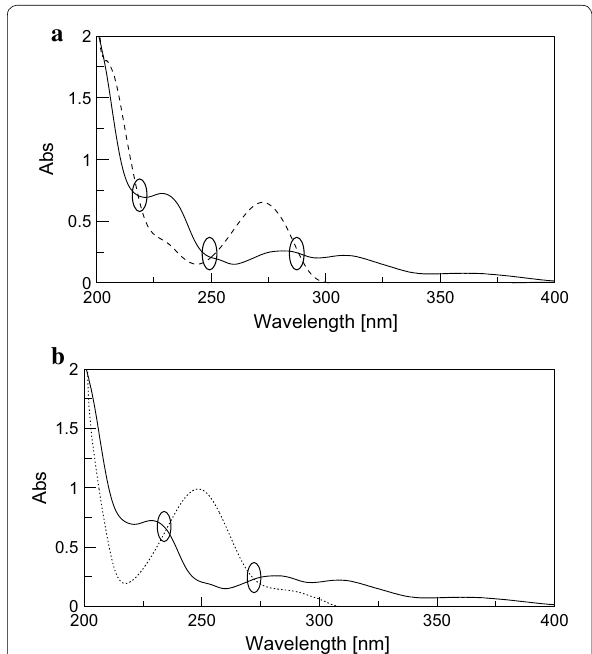
Fig. 8 a Zero order absorption spectra of DRO ( solid line ) and CAF ( dashed line ) showing three isoabsorptive points at 219.2, 252 and 288 nm 10 μg/mL of each. b Zero order absorption spectra of DRO ( solid line ) and PCT ( dotted line ) showing two isoabsorptive points at 233.8 and 273.7 nm 10 μg/mL of